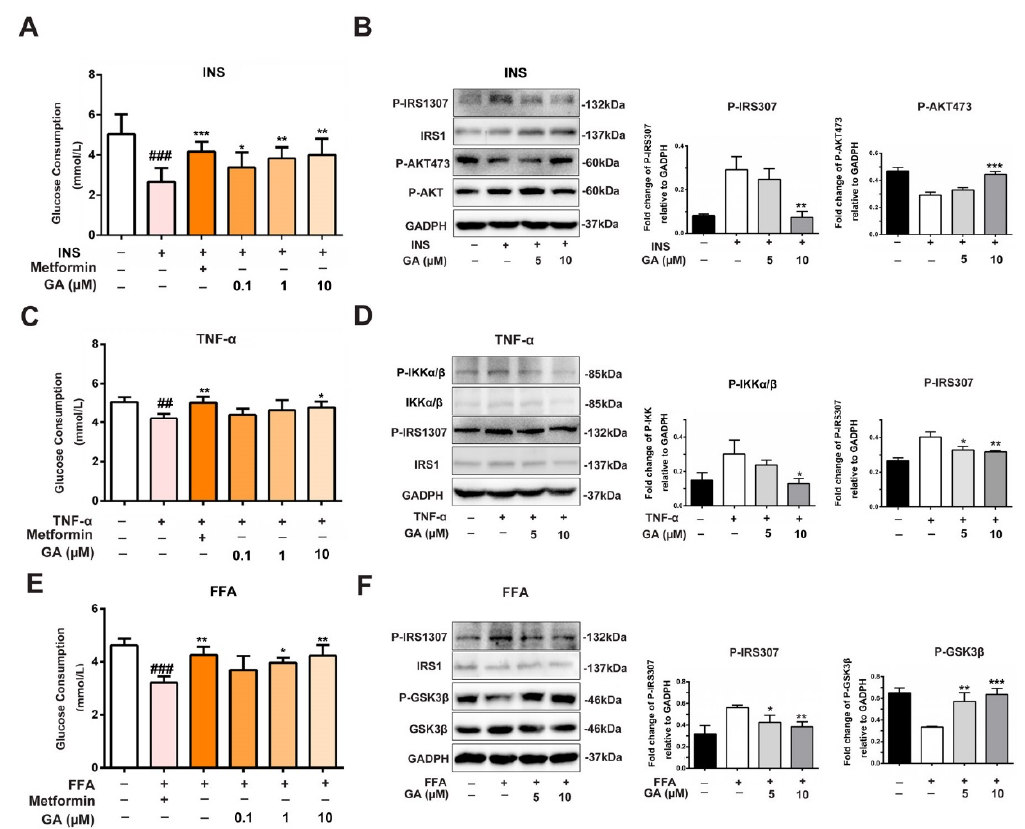
Figure 3. Effect of GA on glucose consumption and insulin-responsive pathway. ( A ) The effect of GA on glucose consumption in the activated insulin signaling pathway. ( B ) A protein level analysis of the upregulation/downregulation of the AKTser473 and IRS1ser307 kinases in the insulin-stimulated HepG2 cells. ( C ) The effect of GA on glucose consumption in the TNF- α -stimulated HepG2 cells. ( D ) A protein level analysis of the upregulation/downregulation of IKK and IRS1ser307kinases in TNF- α -stimulated HepG2 cells. ( E ) The effect of GA on glucose consumption in FFA-stimulated HepG2 cells. ( F ) A protein level analysis of the upregulation/downregulation of the GSK3 β and IRS1ser307 kinases in FFA-stimulated HepG2 cells. The error bars indicate the mean ± S.D. ( n = 3) (* p < 0.05, ** p < 0.01, ## p < 0.01, *** p < 0.001, ### p < 0.001 compared to the activated insulin signaling pathway group).